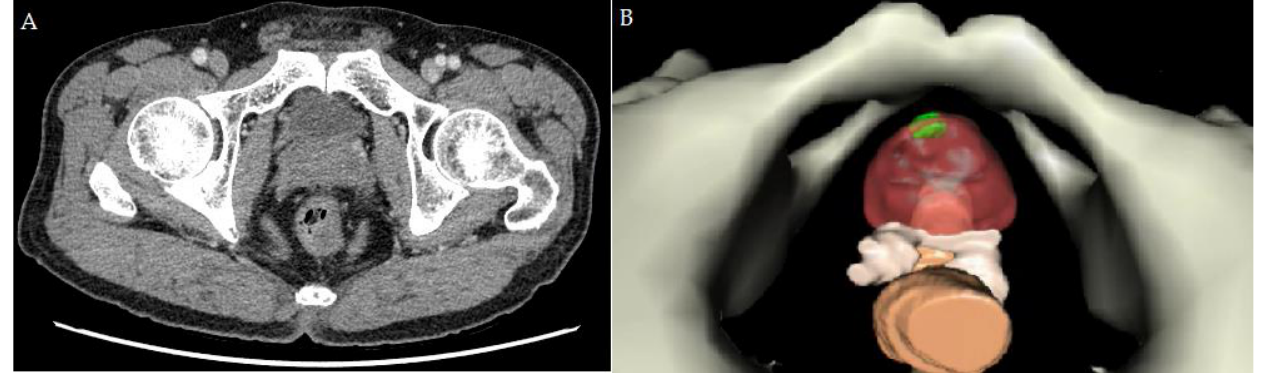
Figure 3. ( A ) The 1.25-mm thin slice for computed tomography used for reconstruction. ( B ) The reconstructed personal 3D image using for RAPP. The green area indicates the location of PCa.